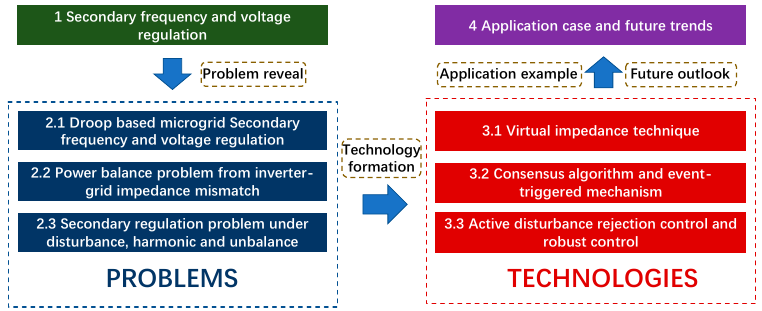
Figure 1. Structure of problems and technologies introduced in the paper.